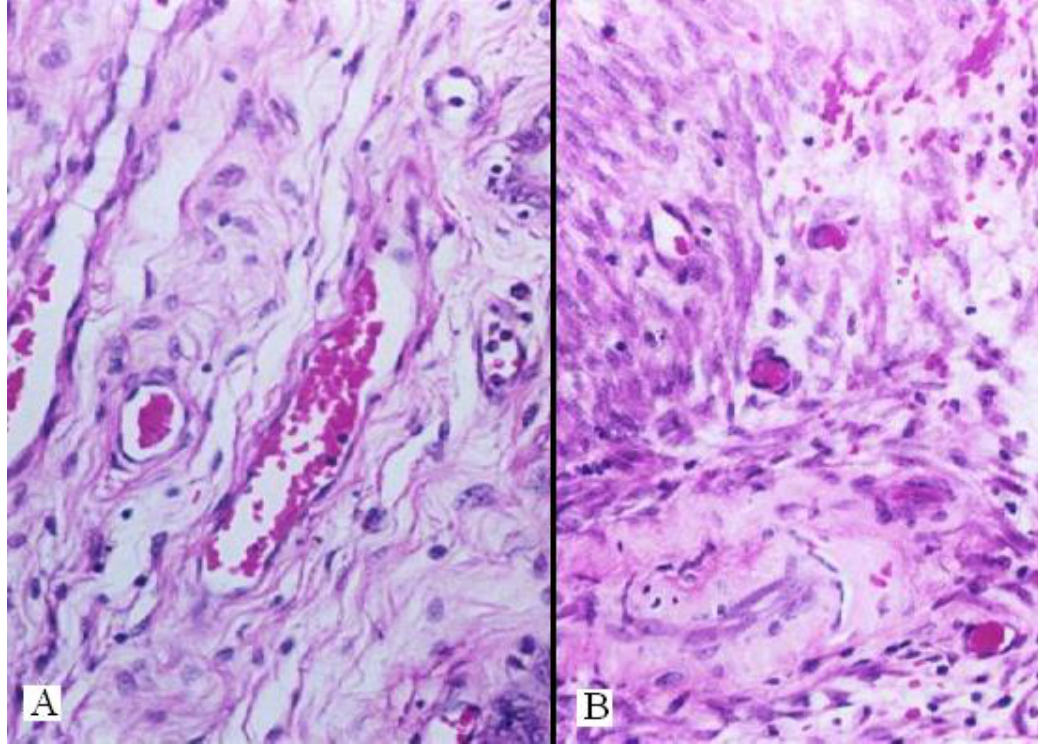
Figure 2. Microscopic aspect of the uterus 15 days after surgery- A = proliferative phase, abundant loose connective tissue, and vascular congestion in G number of neo-vessels and hemorrhage of G